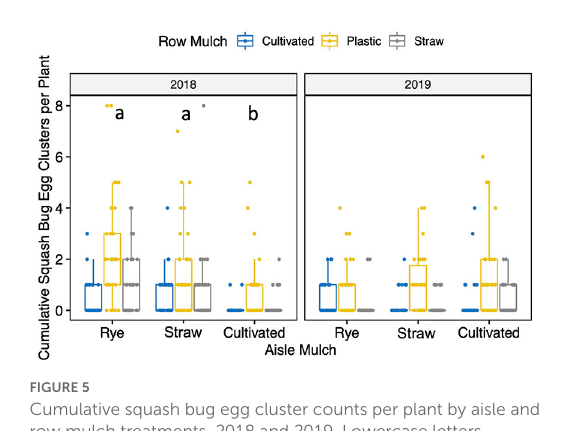
FIGURE5 Cumulative squash bug egg cluster counts per plant by aisle and row mulch treatments, 2018 and 2019. Lowercase letters indicate significance groupings for aisle mulch across row mulch treatments within the same year. Groups with the same letter or no letter were not significantly different at p < 0.05.